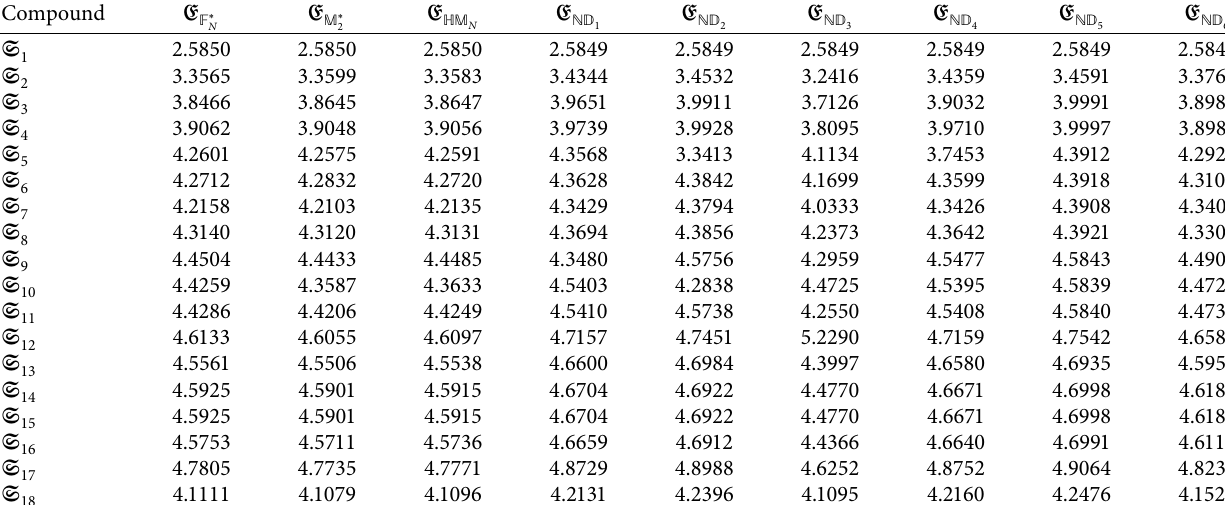
Table 2: Numerical values of neighborhood version of